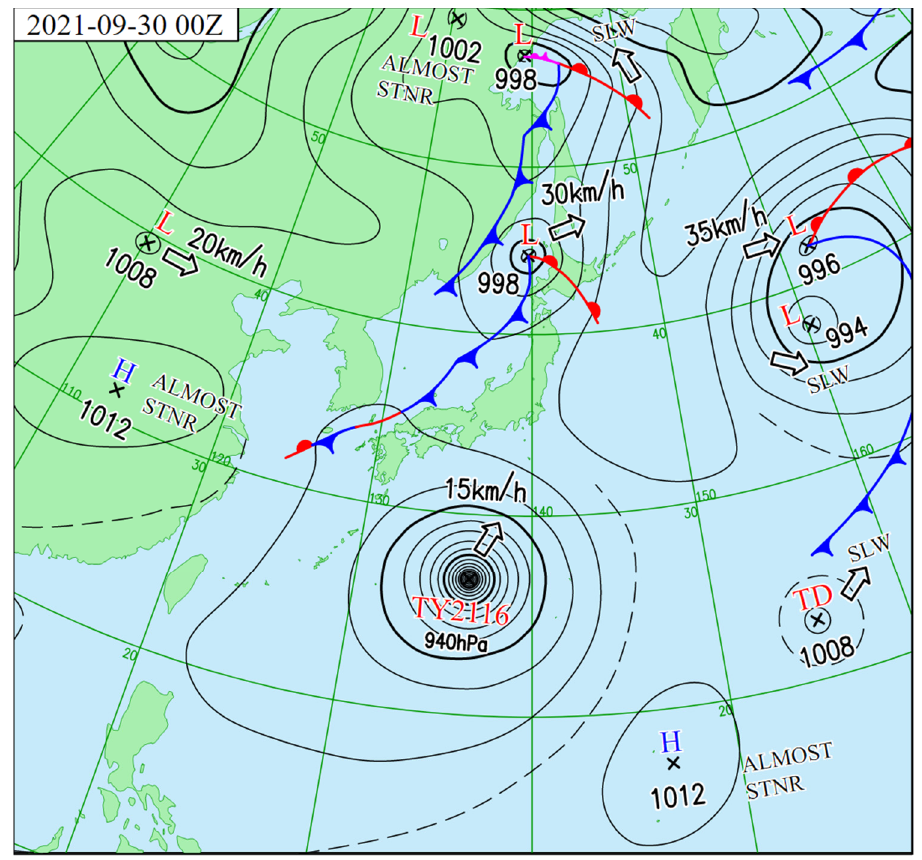
Figure 12. The normal weather map on 30 September. H is high pressure, L low pressure, TD tropical depression and TY is typhoon. Also, SLW means slowly, and STNR means stationary.